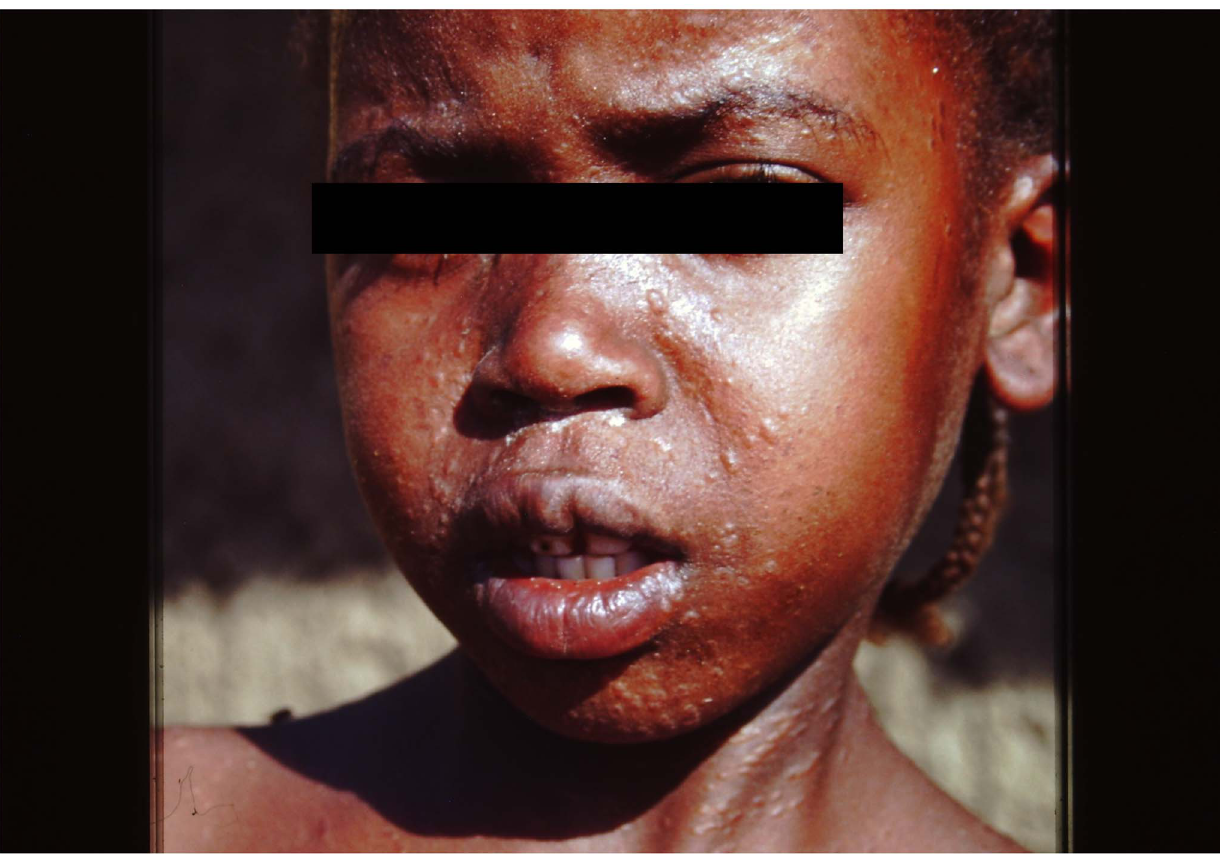
Figure 1. Classical PKDL from Sudan showing a papular rash on the face. The identity of the photographer was known to the patient, who gave permission. (Further images of PKDL can be found in the WHO PKDL atlas: A manual for health workers [36].)